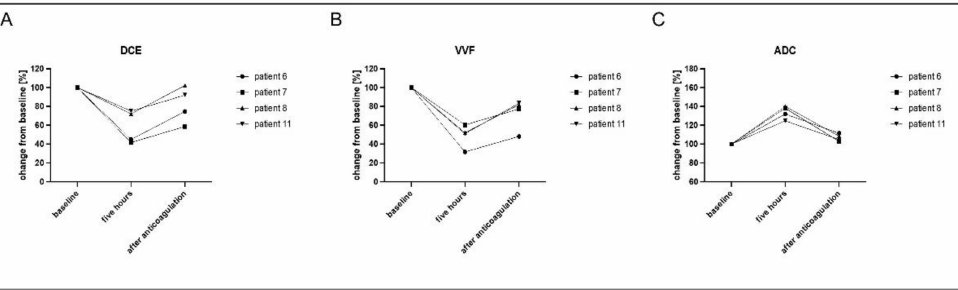
Figure 6. All imaging parameters show a fast normalization of perfusion after effective anticoagulation. Four patients needed a withdrawal of the study medication tTF-NGR due to elevation of troponin T hs or Grade 2 thrombotic events. These patients were immediately anticoagulated with enoxaparin, patient 6 and patient 11 on day 3, patient 7 on day 1 and patient 8 on day 2. Imaging was performed one day after anticoagulation (patient 6, patient 8) or two days after anticoagulation (patient 7, patient 11) and showed the reversibility of the therapeutic effect of tTF-NGR on the parameters DCE ( A ), VVF ( B ) and ADC ( C ). Overall one-way ANOVA was significant for all three parameters (DCE p = 0.0209, VVF p = 0.0044, ADC p = 0.0010).